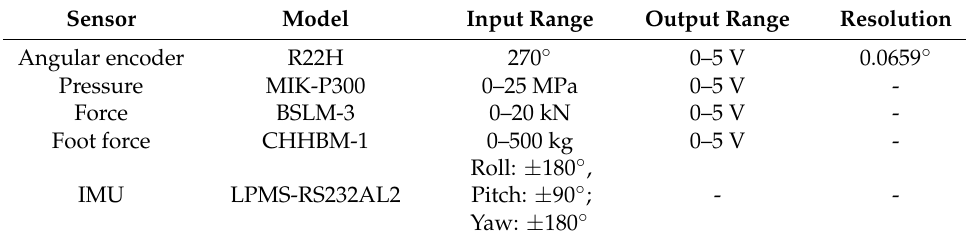
Table 1. List of specifications of different